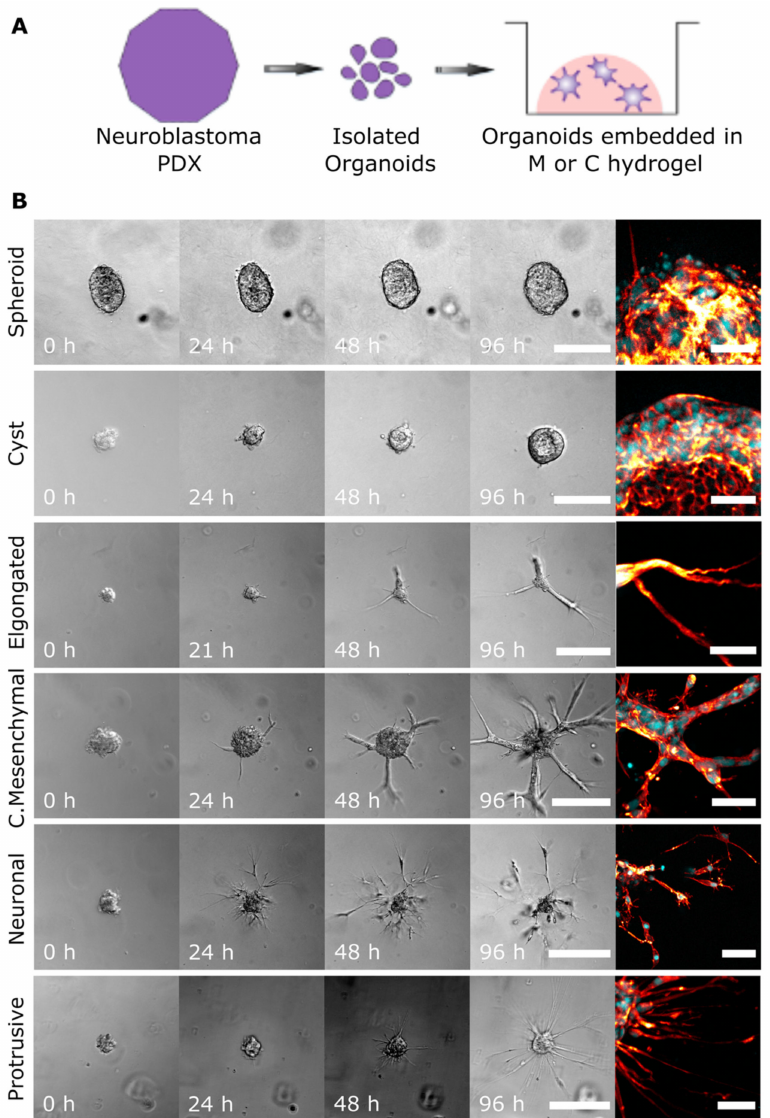
Figure 1. Neuroblastoma (NB) organoids are heterogenous and display a spectrum of distinct invasion strategies in 3D assays. ( A ) Schematic of isolation and 3D culture of human neuroblastoma clusters. Matrigel, M, Collagen, C hydrogels. ( B ) Representative DIC time-lapse and confocal images of organoids isolated from Felix-patient-derived xenograft (PDX) and grown in 3D extracellular matrix (ECM) cultures. Confocal images, taken on day 5 of 3D culture, show nuclei stained with DAPI (cyan) and actin filaments stained with phalloidin (red). Based on the morphology NB, organoids were classified as non-invasive (spheroid, cyst) or invasive (elongated, collective mesenchymal, neuronal or protrusive). For spheroid and cyst: DIC scale bars = 100 µ M, confocal scale bars = 30 µ M, elongated DIC scale bars = 150 µ M, confocal scale bars = 30 µ M. For all remaining DIC images: scale bars = 200 µ M, confocal scale bars = 50 µ